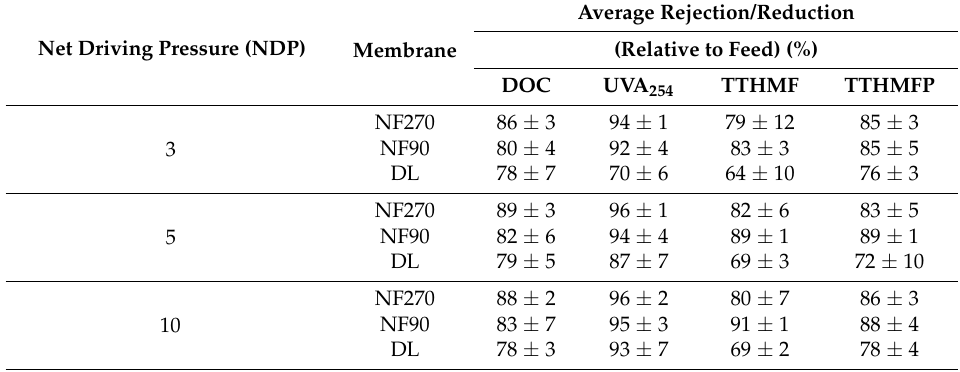
Table 1. Average rejection (R) in dissolved organic carbon (DOC) and 254 nm absorbance (UVA 254 ) and resulting reductions in total trihalomethane (THM) formation (TTHMF) and total THM formation potential (TTHMFP), as a function of membrane type and feed